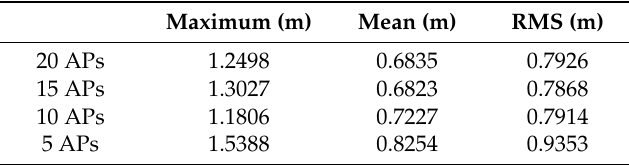
Table 5. Positioning errors using different numbers of